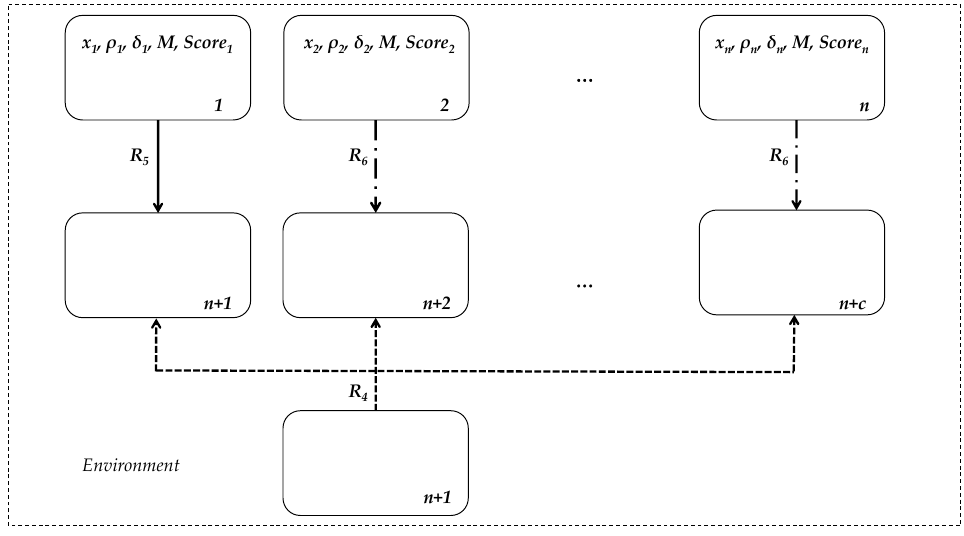
Figure 4. The realization process of the tissue — like P system.